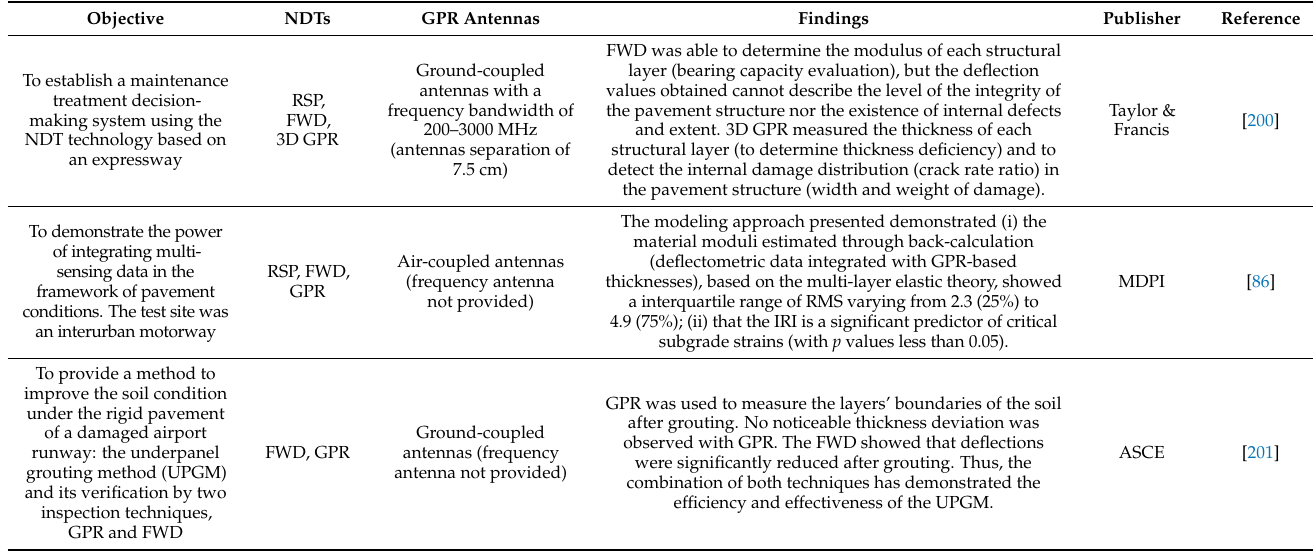
Table 2. Relevant published works combining GPR with other NDTs on road pavement assess- ment.